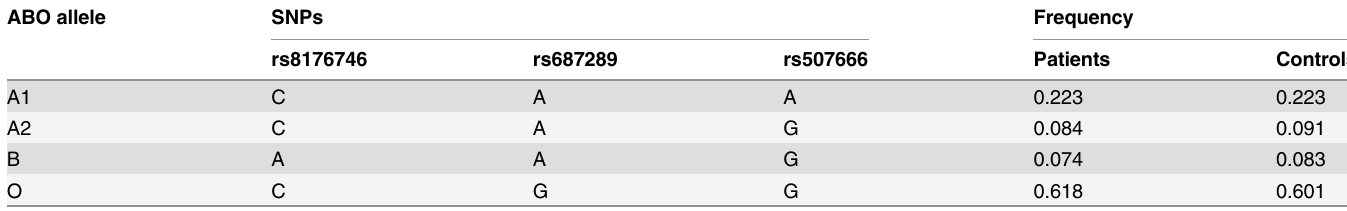
The table shows the combination of alleles at three different SNPs that represent the four major ABO antigens. The frequency for inferred antigen is shown for ACS patients and controls separately. No difference in frequency were seen between ACS patients and controls for any of the antigens ( P > 0.05).